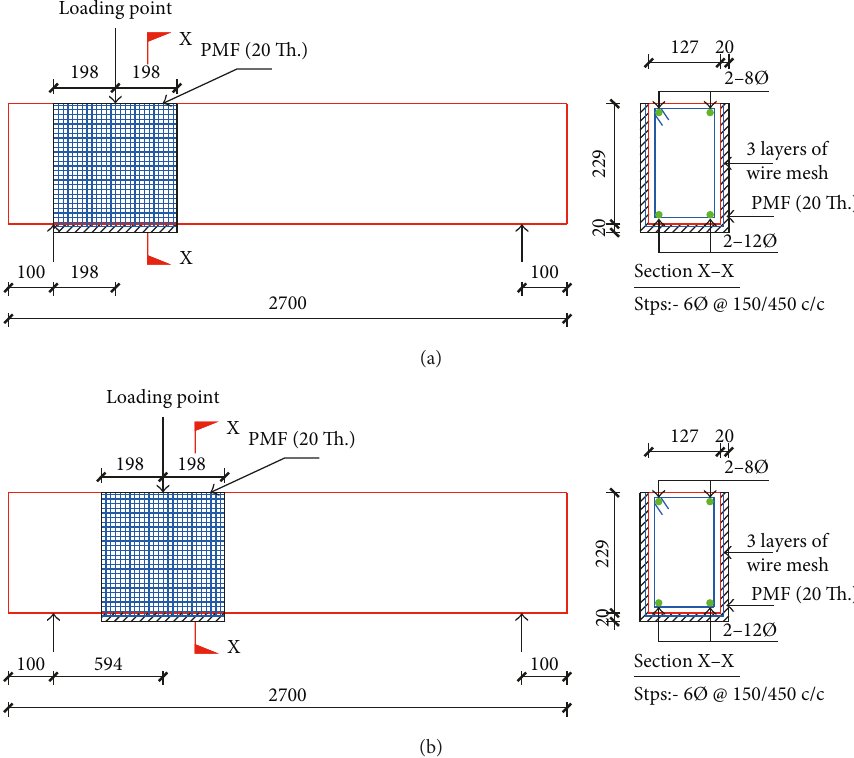
Figure 3: Detail of PMF strengthening: (a) beams tested at a / d � 1; (b) beams tested at a / d � 3.